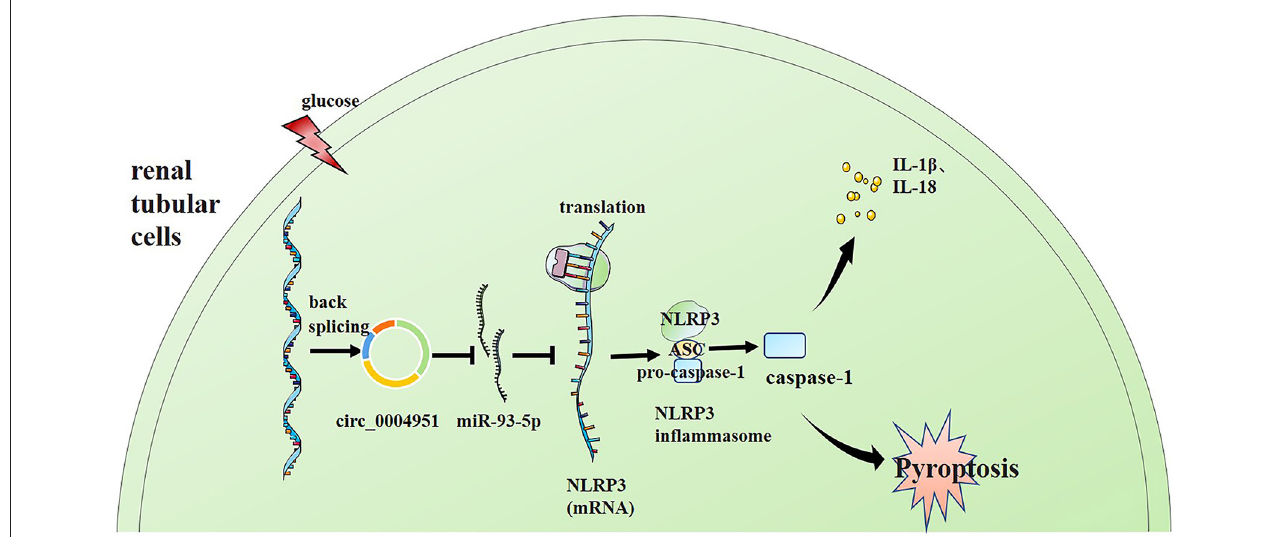
FIGURE 6 | Schematic representation of the proposed molecular mechanism showing that pyroptosis of renal tubular cells occurs via the “circ_0004951/miR-93-5p/NLRP3 inflammasome” axis in DKD. DKD, diabetic kidney